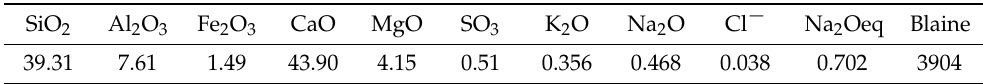
Table 2. Composition of ground blast furnace slag (GGBFS).